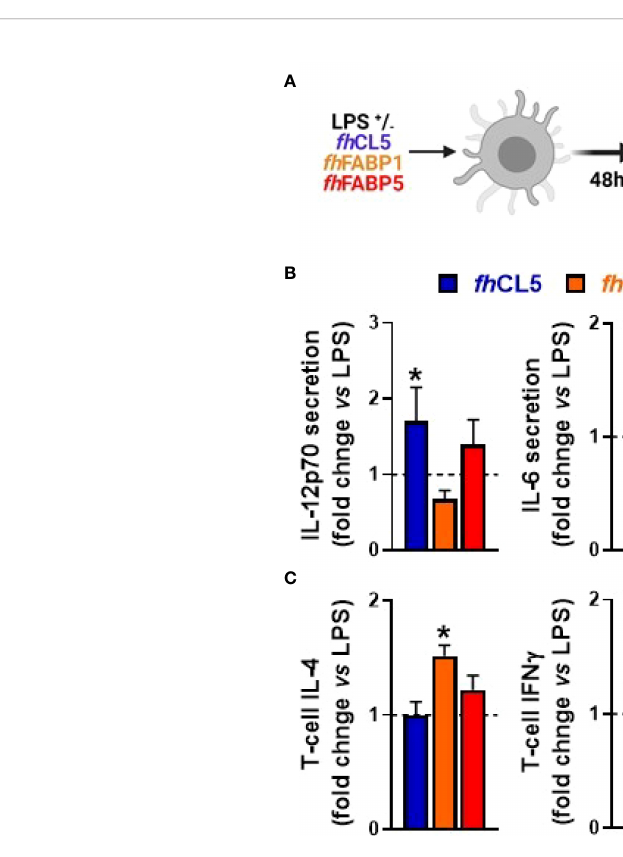
FIGURE 2 | Fasciola hepatica FABP1, but not CL5 and FABP5, conditions dendritic cells to prime different T cell subsets Human monocyte-derived DCs (moDCs) were treated for 48 h with or without 25 µg/ml recombinant Fasciola hepatica cathepsin L5 ( fh CL5, blue bars), Fatty Acid Binding Protein 1 ( fh FABP1, orange bars) or Fatty Acid Binding Protein 5 ( fh FABP5, red bars) in the presence of LPS (100 ng/ml) (A) Conditioned moDCs were characterized by cytokine production after 48 hours (B) and their capacity to prime CD4 + T cell responses (C) after 11 days of co-culture, as described in Figure 1 . All data are expressed relative to the DCs stimulated with LPS alone (dash line) as mean ± SEM * P ≤ 005 vs LPS alone (n=3 independent